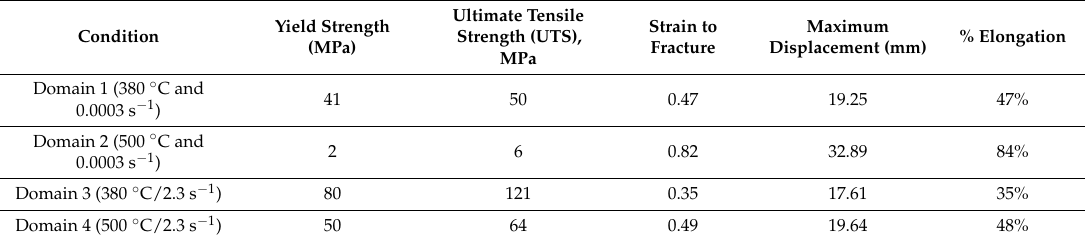
Table 1. The tensile mechanical properties of the specimens that correspond to the four domains in the processing maps of the extruded ABaX422